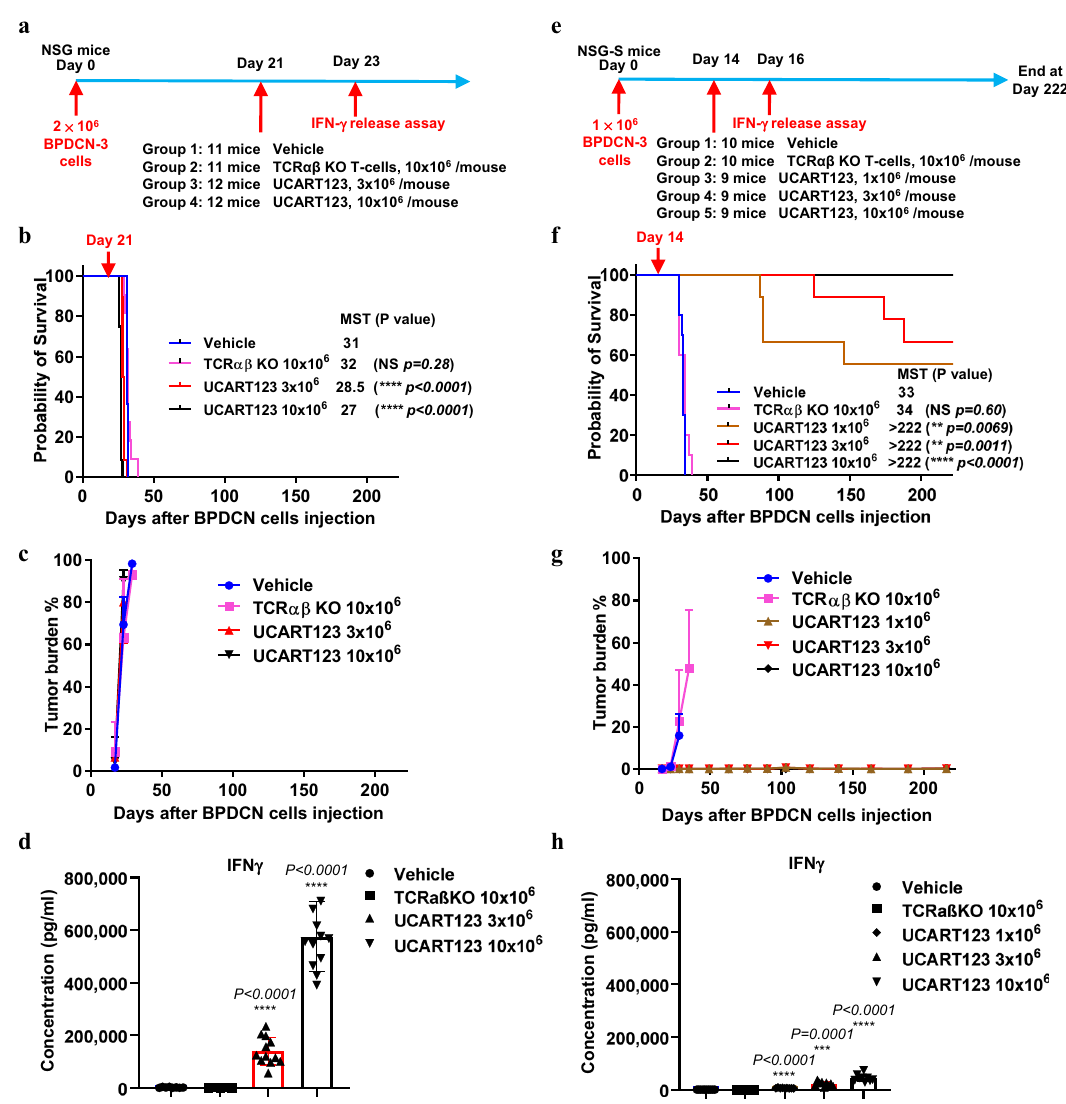
Fig. 4 Evidence of severe cytokine release at high tumor burden in the PDX-2 BPDCN experiment. a Experimental design using BPDCN-3 cells. When engraftment was con fi rmed on day 21 after tumor cell injection (0.1 – 23.5% circulating BPDCN), mice were randomized into 4 treatment groups (n = 11-12 mice/group) and received treatment as follows: vehicle; 10 × 10 6 TCR αβ KO T cells; 3 × 10 6 UCART123 cells; or 10 × 10 6 UCART123 cells by single tail vein injection. b Survival among the treatment groups was estimated by the Kaplan-Meier method. MST = median survival time (in days). c High baseline and rapidly progressing tumor burden in all cohorts. The mean ± SD value is presented. d Mice in the UCART123-treated groups, which had a high tumor burden when treatment began, died earlier than control mice, showing high levels of IFN γ in peripheral blood samples at Day 2 following T cells injection. The mean ± SD value is presented. e Experimental design of a separate experiment with PDX-2 experiment. In this study, mice injected with BPDCN-3 (1×10 6 tumor cells/mouse) received similar treatment, this time in 5 groups (3 UCART123 doses; n = 9 – 10 mice/group) that was initiated on day 14 after injection of tumor cells, when tumor burden was low (0% circulating BPDCN, 0.9 – 1.1% engraftment in the bone marrow). f – h UCART123 extended survival ( f ) and reduced or eliminated circulating BPDCN cells ( g ; no engraftment was seen in cohorts that received 3 or 10 × 10 6 UCART123) when therapy initiated at a low tumor burden. IFN γ levels in peripheral blood were measured 2 days following T cell injection ( h ) and were considerably lower than in the 1 st study. MST = median survival time (in days). The mean ± SD value is presented. For b , d , f , h , Compare to vehicle group: Signi fi cance was determined using unpaired two-tailed t-test annotated as “ NS ” (not signi fi cant , p ≥ 0.05), **P ≤ 0.01, *** P ≤ 0.001, **** P < 0.0001. Source data are provided as a Source data fi